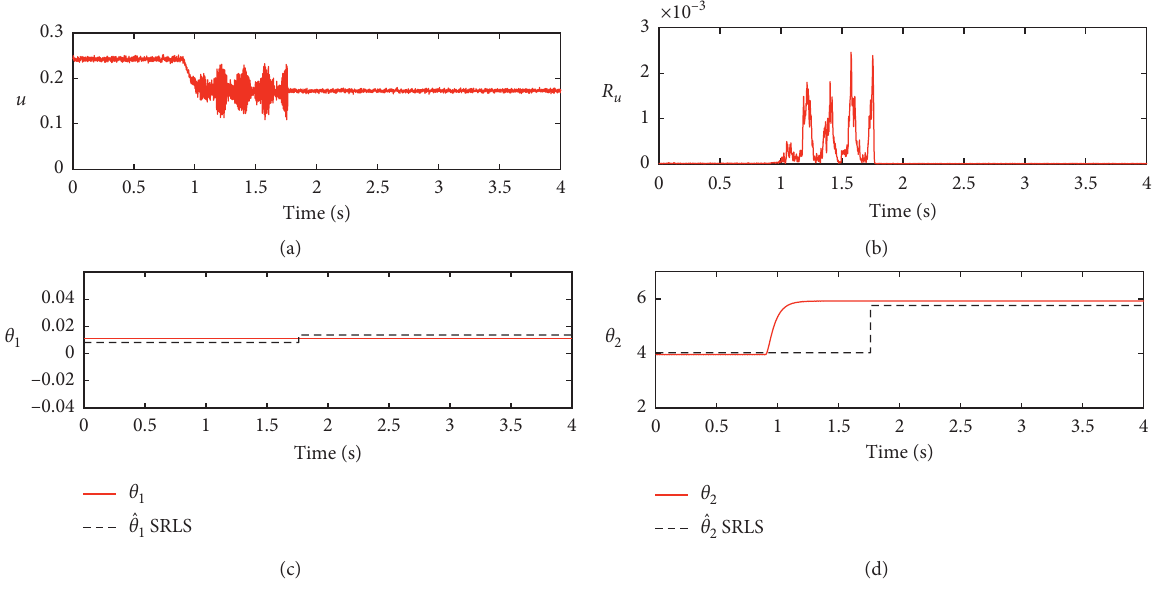
Figure 13: Parameter estimation results with source voltage